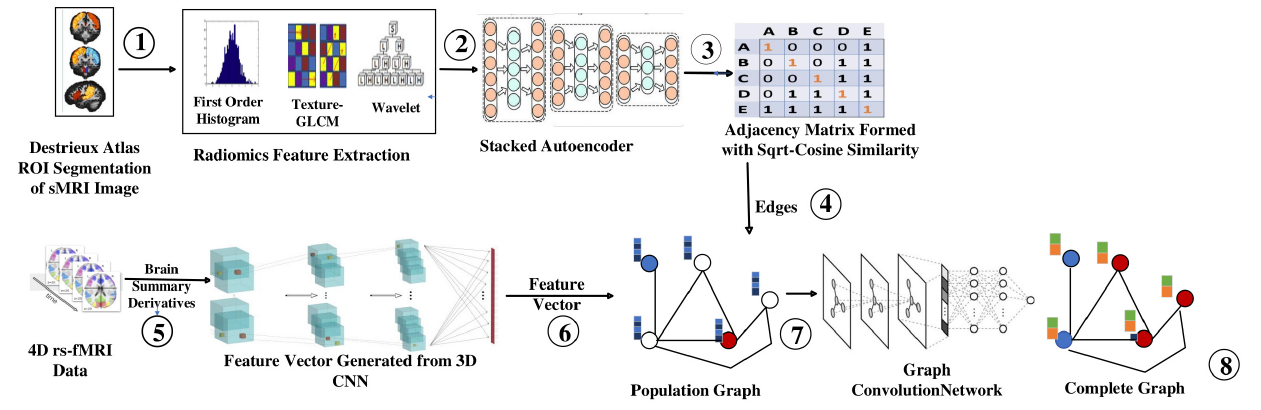
Figure 3. Workflow of Proposed Model. (1: ROI Extraction, 2: Features through Fischer’s Score, 3: Features through Stacked Autoencoder, 4: Builing Adjacency Matrix, 5: Extraction of Summary Measures, 6: Building Feature Vector for Each Node, 7: Constructing Population Graph, 8: Complete Graph using